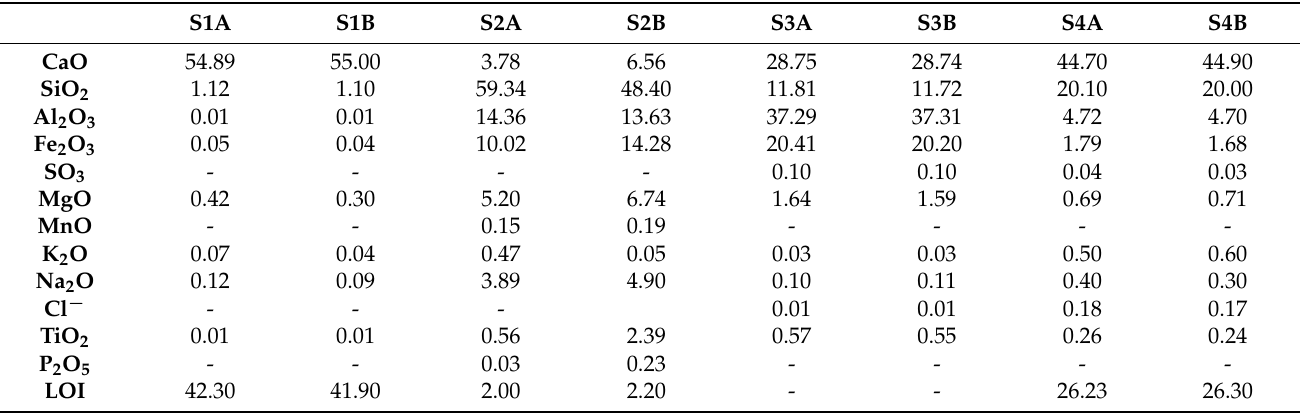
Table 2. Geochemical analysis results of the tested